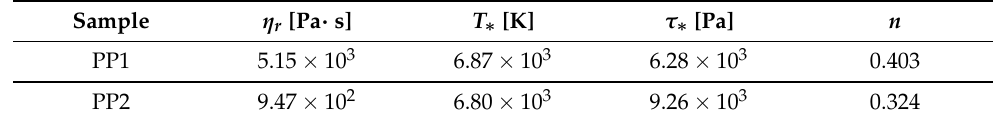
Table 1. Parameters of Cross model for PP1 and PP2 with T r = 473 K.